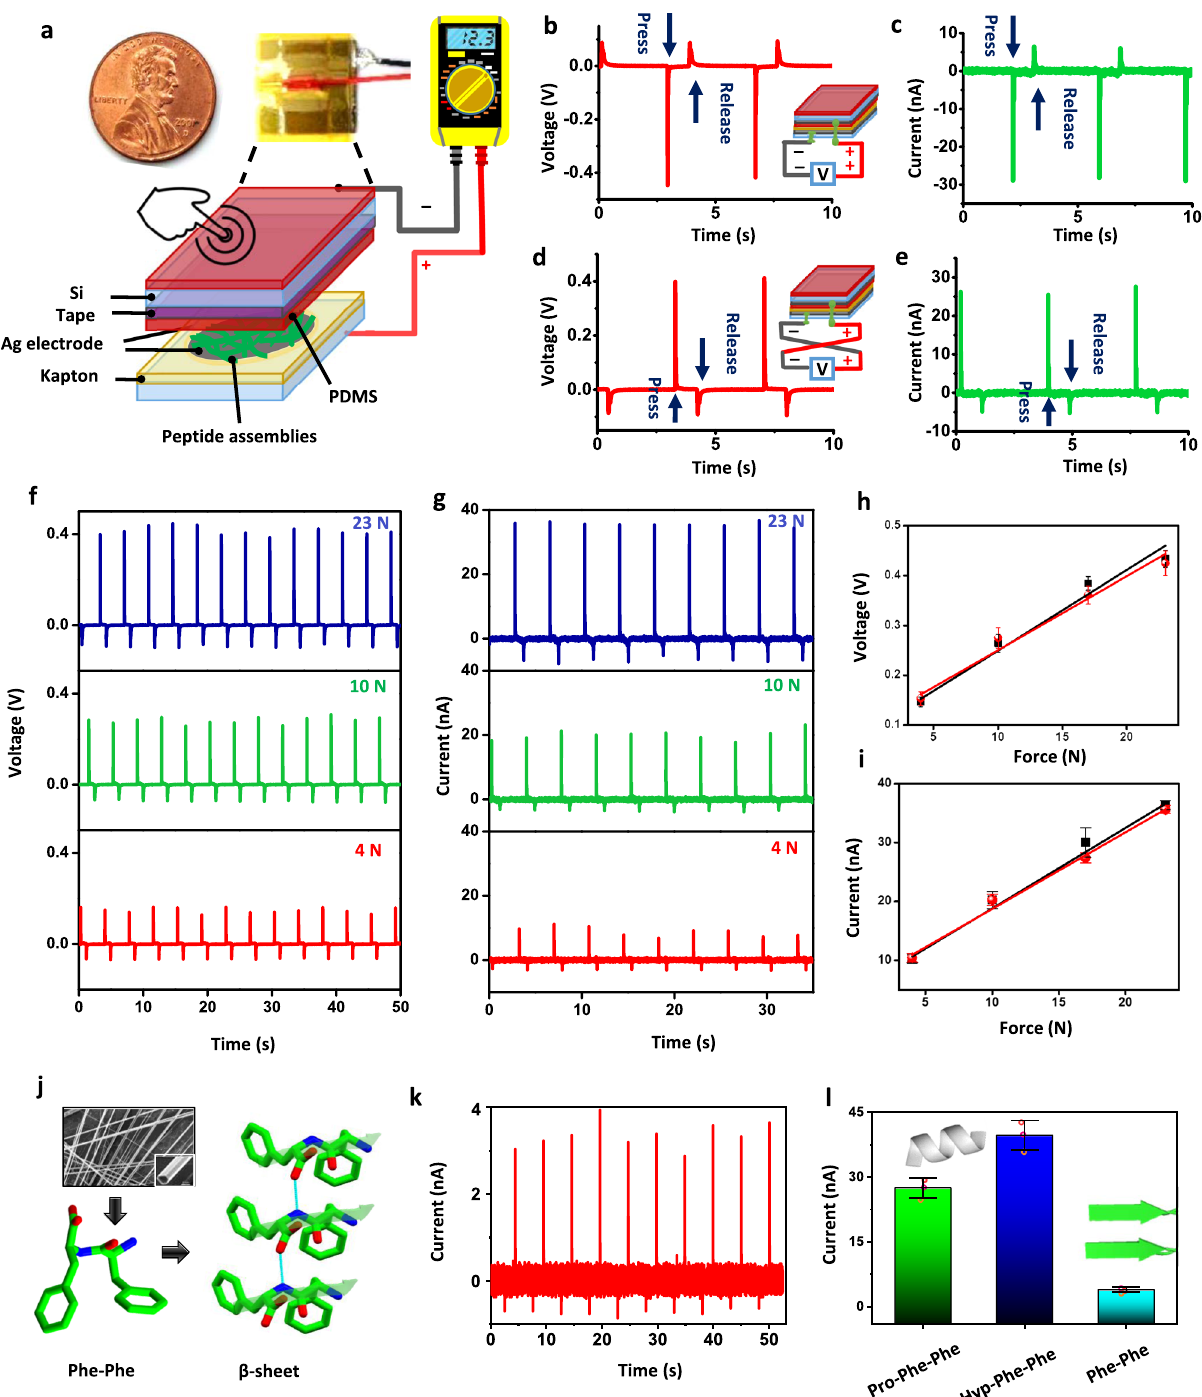
Fig. 4 Characterization of the helical peptide-based nanogenerator. a Photograph and schematic con fi guration of coin-sized piezoelectric energy generation measurement set-up utilized as a direct power source with peptide assemblies as the active component. b , c Open-circuit voltage ( b ) and short- circuit current ( c ) of piezoelectric energy harvester in the forward connection. d , e The generated voltage output ( d ) and current output ( e ) in the reverse connection. f , g Variable external load was applied onto the device. The measured open-circuit voltage ( f ) and short-circuit current output ( g ) of Hyp-Phe- Phe under different applied force. h , i Linear dependence of the voltage ( h ) and current ( i ) output on the applied force. The black and red lines indicate forward and reverse connection, respectively. j – l Comparison of piezoelectric response of the engineered helical tripeptides with β -sheet forming Phe-Phe peptide assemblies. j The self-assembled nanostructures and β -sheet molecular arrangement in the crystal structure of Phe-Phe (CCDC ref. no 16340 83 ). k Short circuit current obtained from the generator using Phe-Phe assemblies as the active component upon applied force = 23 N. l Comparison of output current of Phe-Phe with helical peptides, Pro-Phe-Phe and Hyp-Phe-Phe. Error bars = SD ( n =